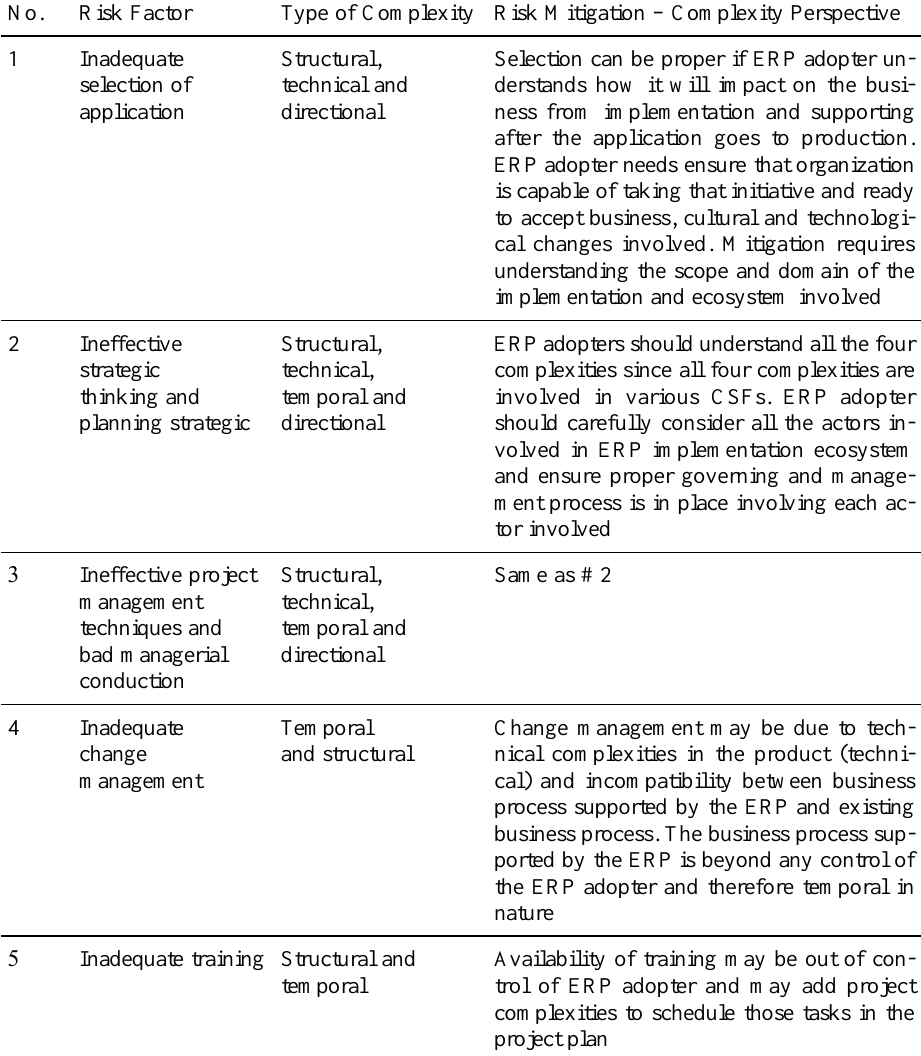
Table 2. Evaluation of complexities to mitigate key ERP risk factors (RFs only adopted from Aloini